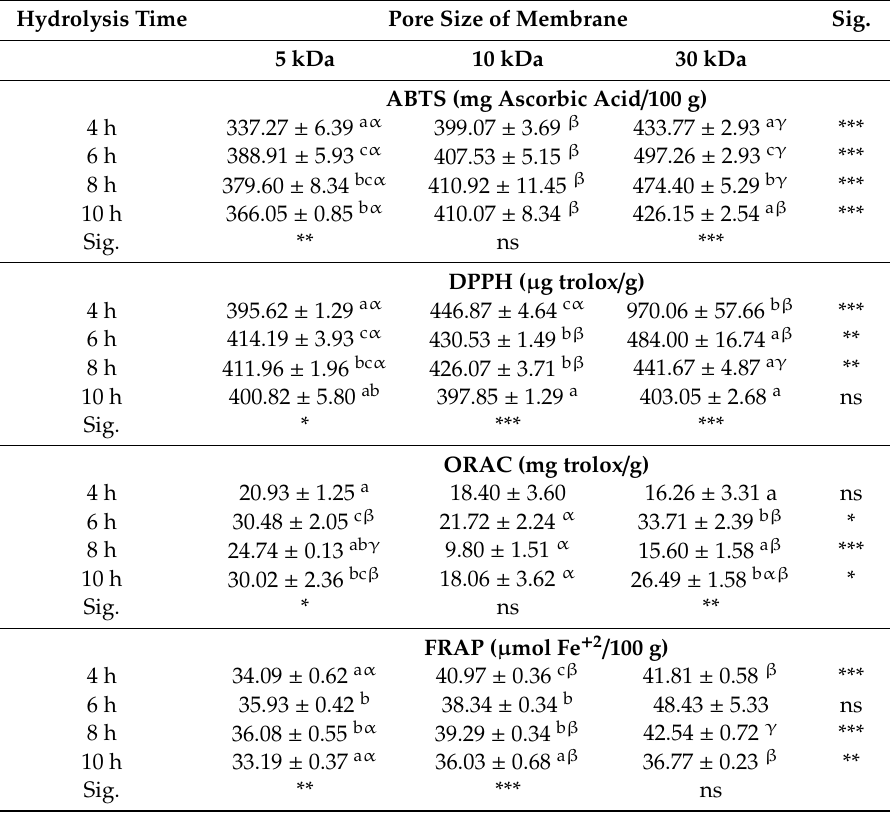
Table 2. E ff ect of hydrolysis time of Flavourzyme and membrane pore size on antioxidant activity of liver porcine